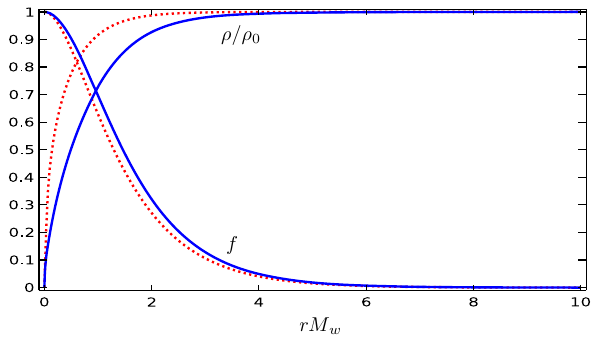
Fig. 1 The electroweak monopole solutions. The red curves represent thesingularCho–Maisonmonopoleobtainedby(15)andthebluecurves represent the finite energy electroweak monopole obtained by (21) with A = B = 0